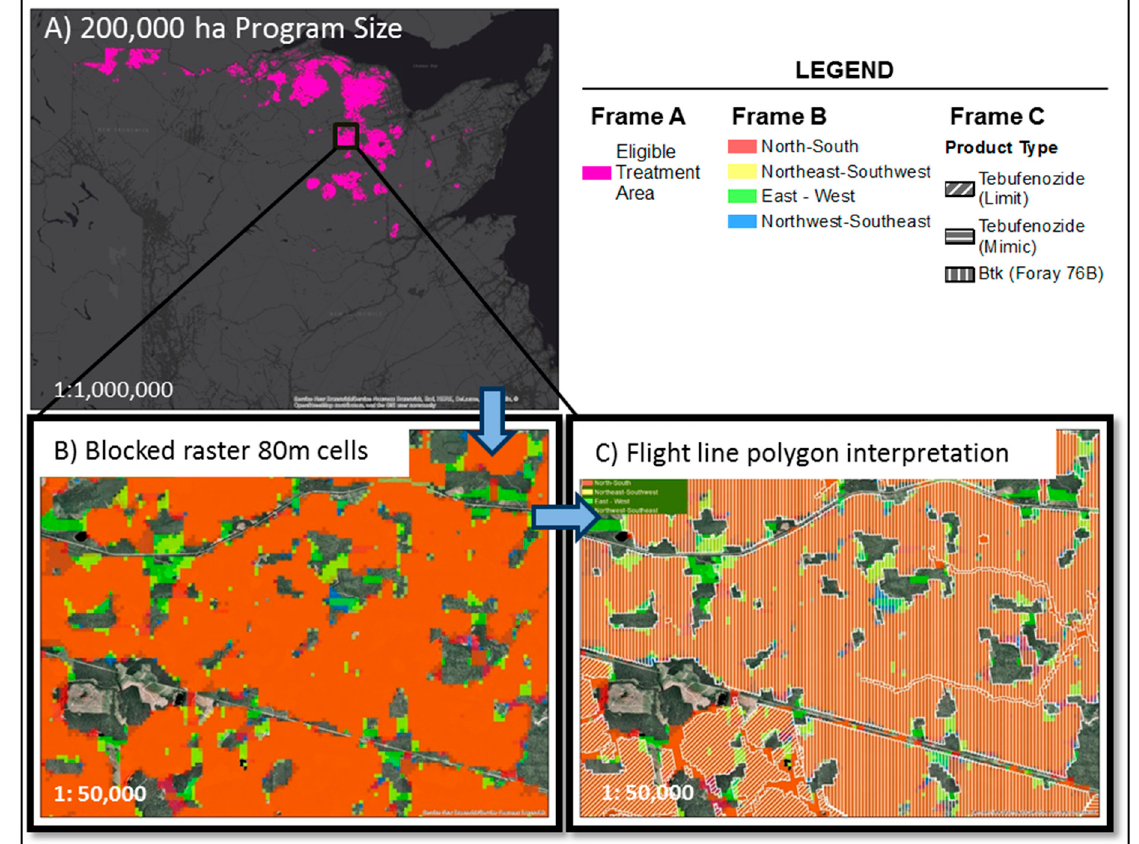
Figure 4. Optimum blocked raster solution ( A, B ) generated by ForPRO II for the 2018 EIS SBW treatment priority layer (Figure 3D) and C ) adjusted final polygon blocks digitized by FPL analysts.